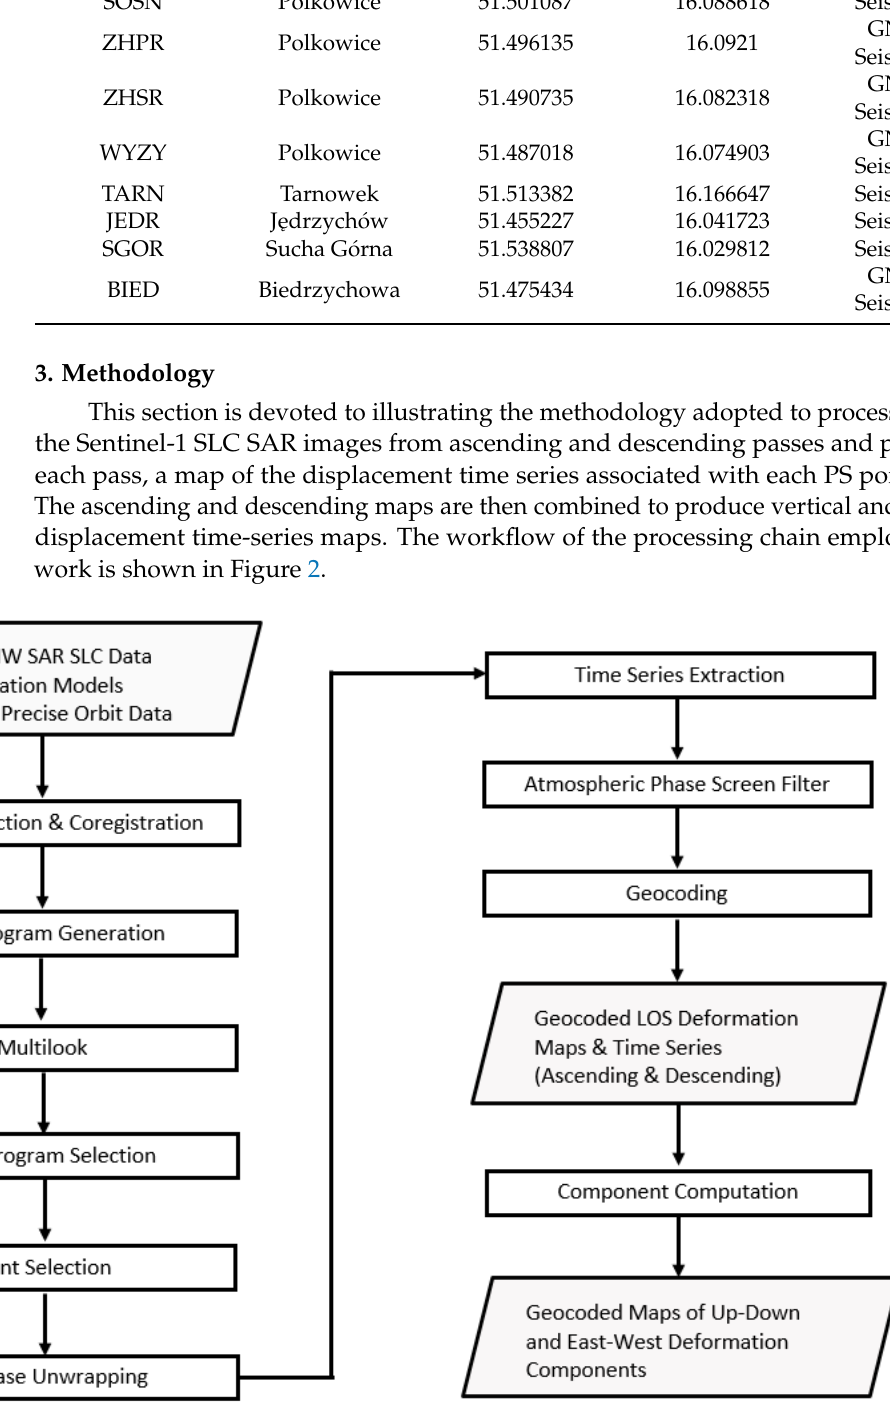
Figure 2. Workflow of the multitemporal MTInSAR processing chain